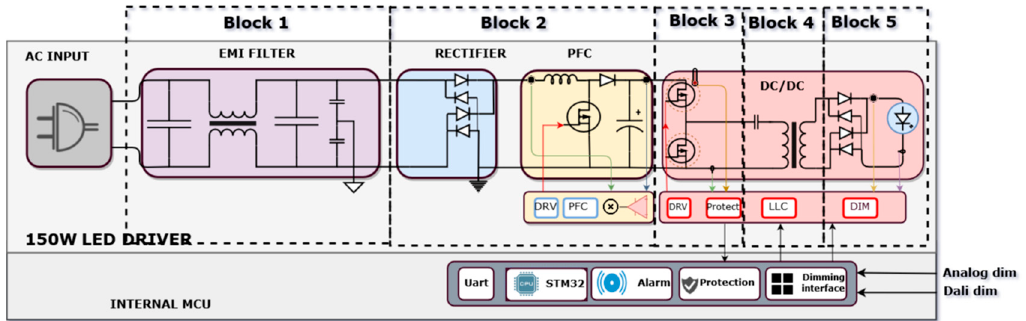
Figure 1. Two-stage LED driver topology with dimmable control. Figure 1. Two ‐ stage LED driver topology with dimmable control. Figure 1. Two ‐ stage LED driver topology with dimmable control.